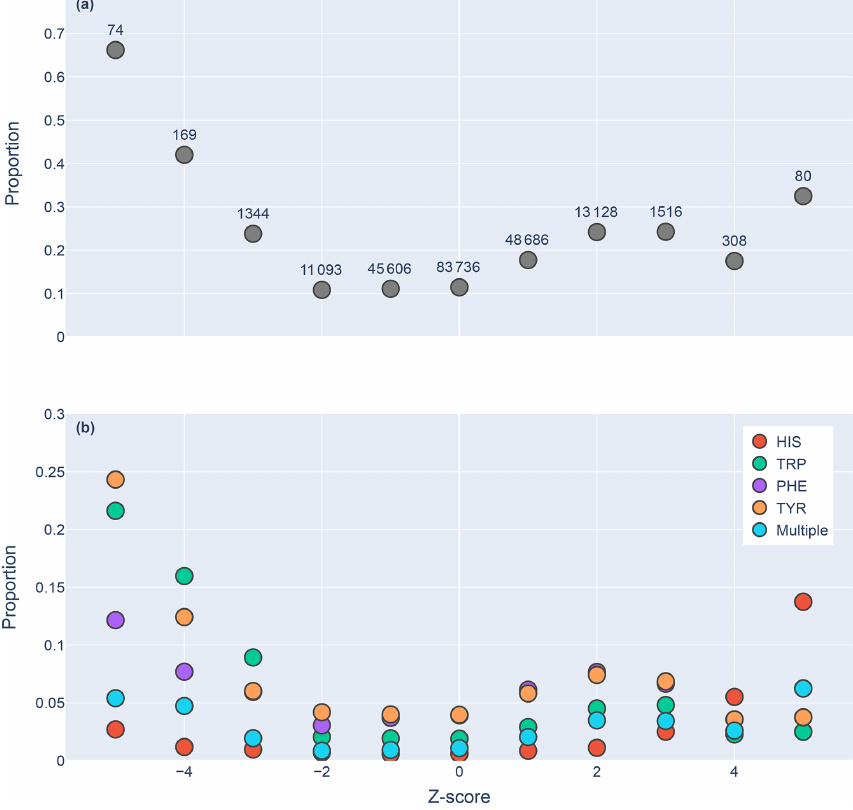
Figure 5. Proportions of amide protons with at least one NOE restraint to an aromatic ring proton ( y axis), as a function of the Z score of the amide proton ( x axis). Proportions are calculated with respect to the total number of amide hydrogens with chemical shifts reported in entries with at least one amide–aromatic restraint. The numbers over each point in panel (a) are the total number of such amides (including those lacking any NOE restraints to a nearby aromatic) with that Z score. In panel (b) , the restrained amide protons are further demarcated by the type of aromatic sidechain to which they are